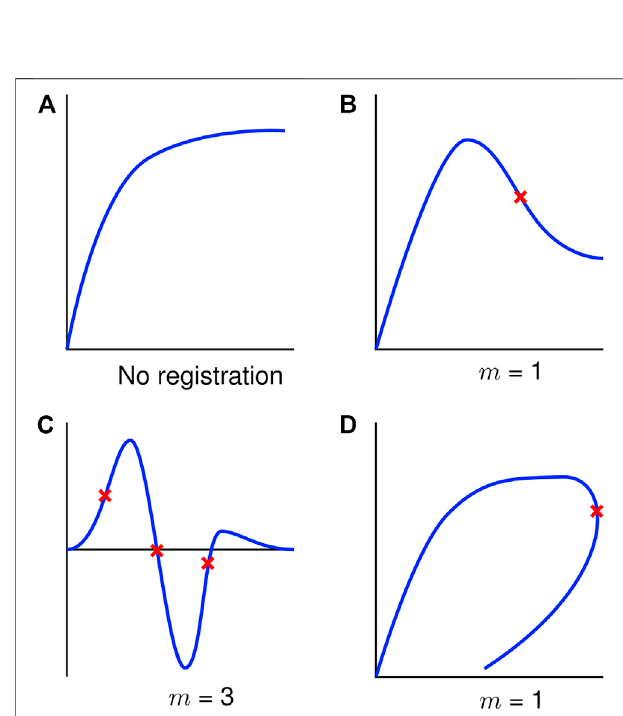
FIGURE 4 | Exemplar signals to aid in selecting the number of control points ( m ) with prominent in fl ection points denoted with red crosses (A) Monotonic signal, no warping needed. (B) Non-monotonic, a single control point isused in this signal due tothe single in fl ection point (C) Oscillatory signal, three control points corresponding to three in fl ection points. (D) Load- unload signal, one warping point is required for a single in fl ection point in x versus arc-length